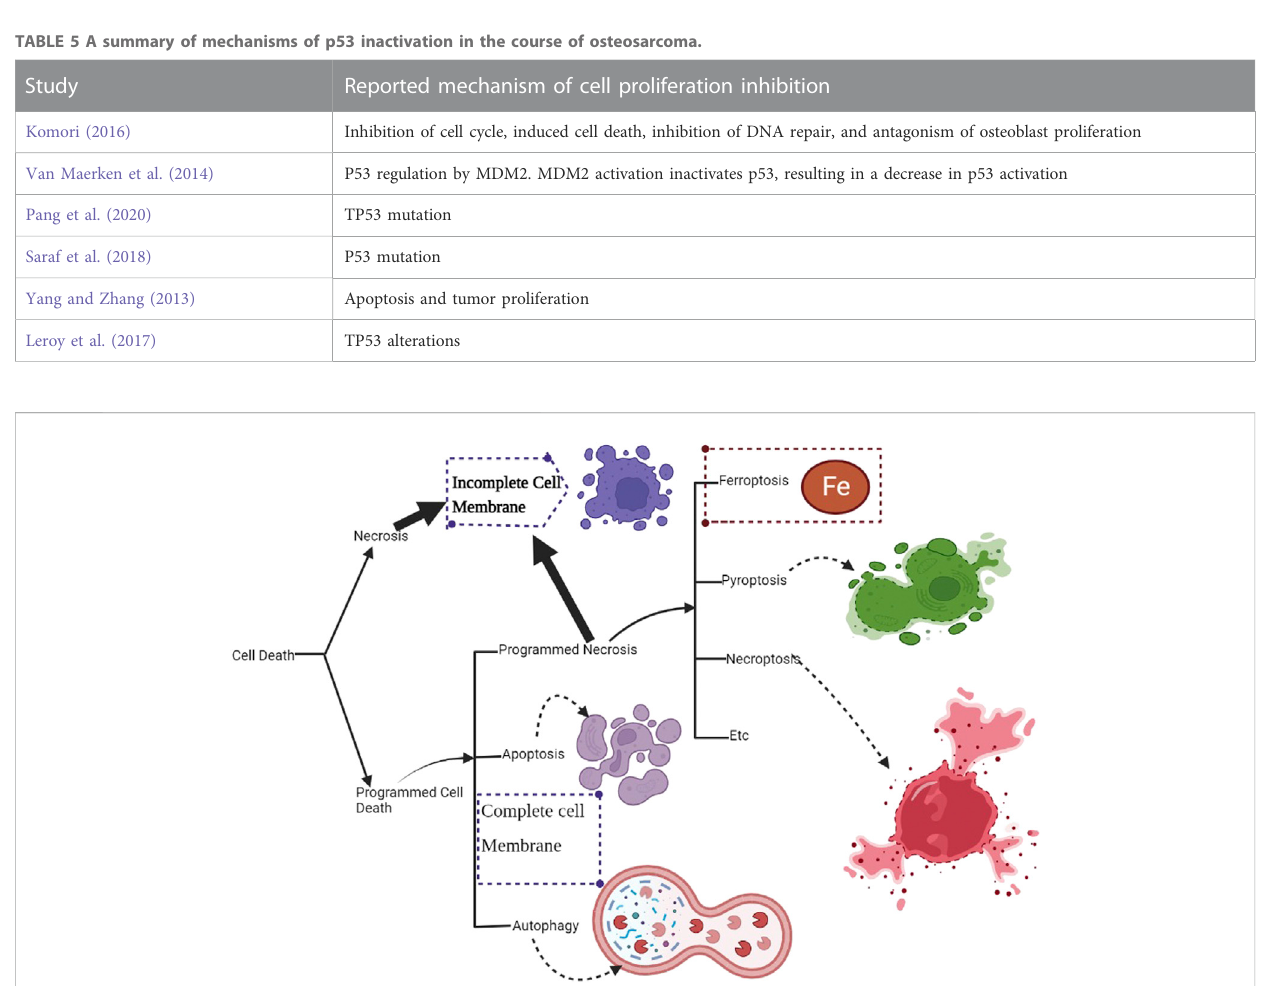
FIGURE 8 An illustration of p53 ’ s role in ferroptosis. Cell death mediated by p53 is largely dependent on programmed necrosis. Programmed cell death mediates iron-dependent cell death,